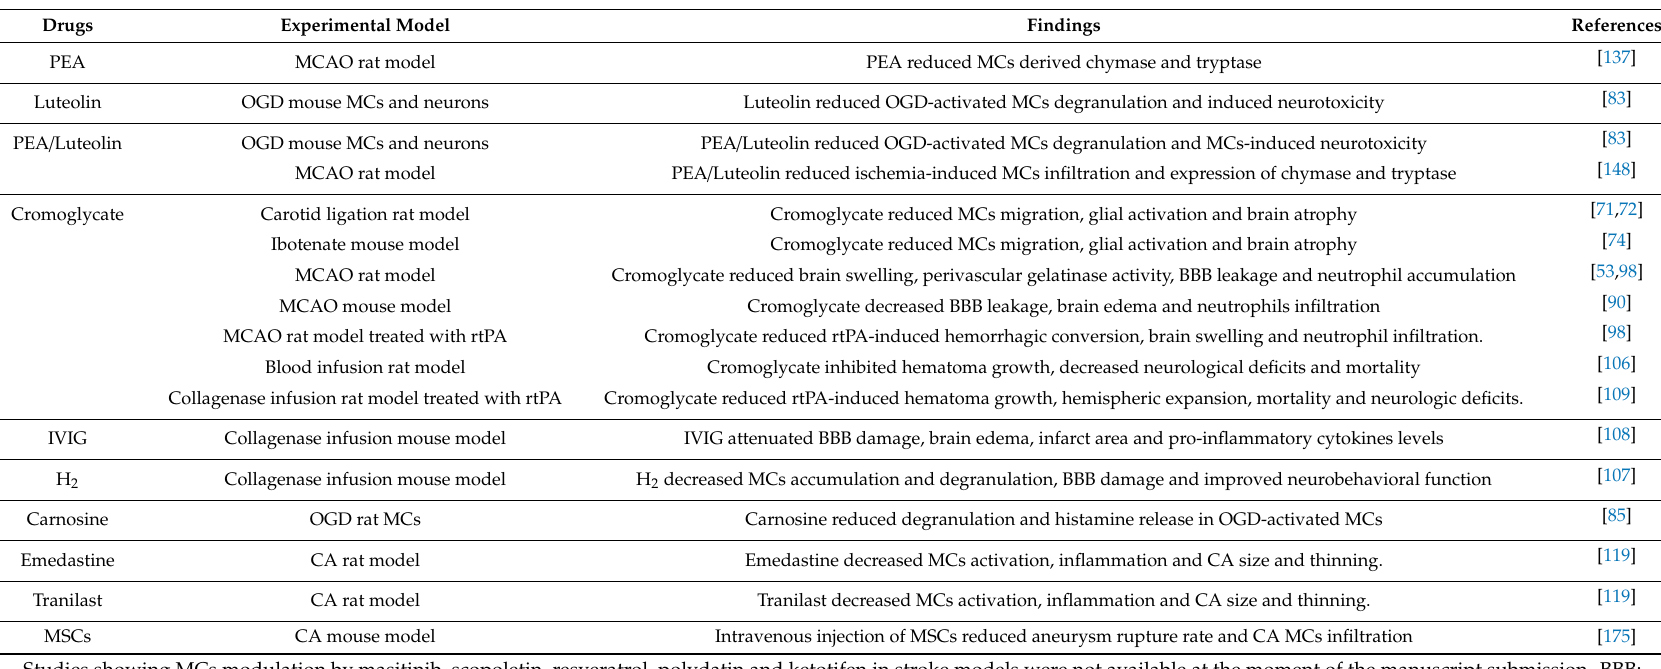
Table 2. Therapeutic modulation of MCs in stroke